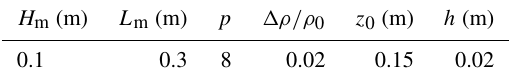
Table 1. Stratification parameters.